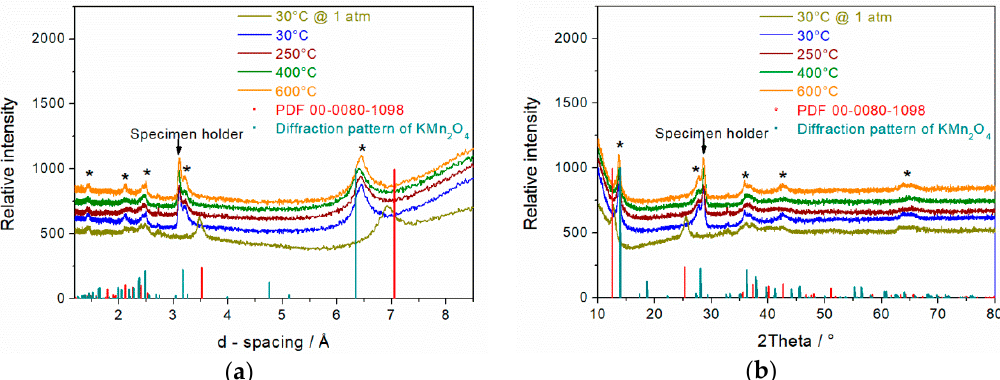
Figure 5. In-situ XRD diffraction pattern of δ -MnO 2 (14 h @ 110 °C in 1.6 M KOH); All patterns at respective temperatures were recorded under vacuum except 30 °C at 1 atm ( a , b ).